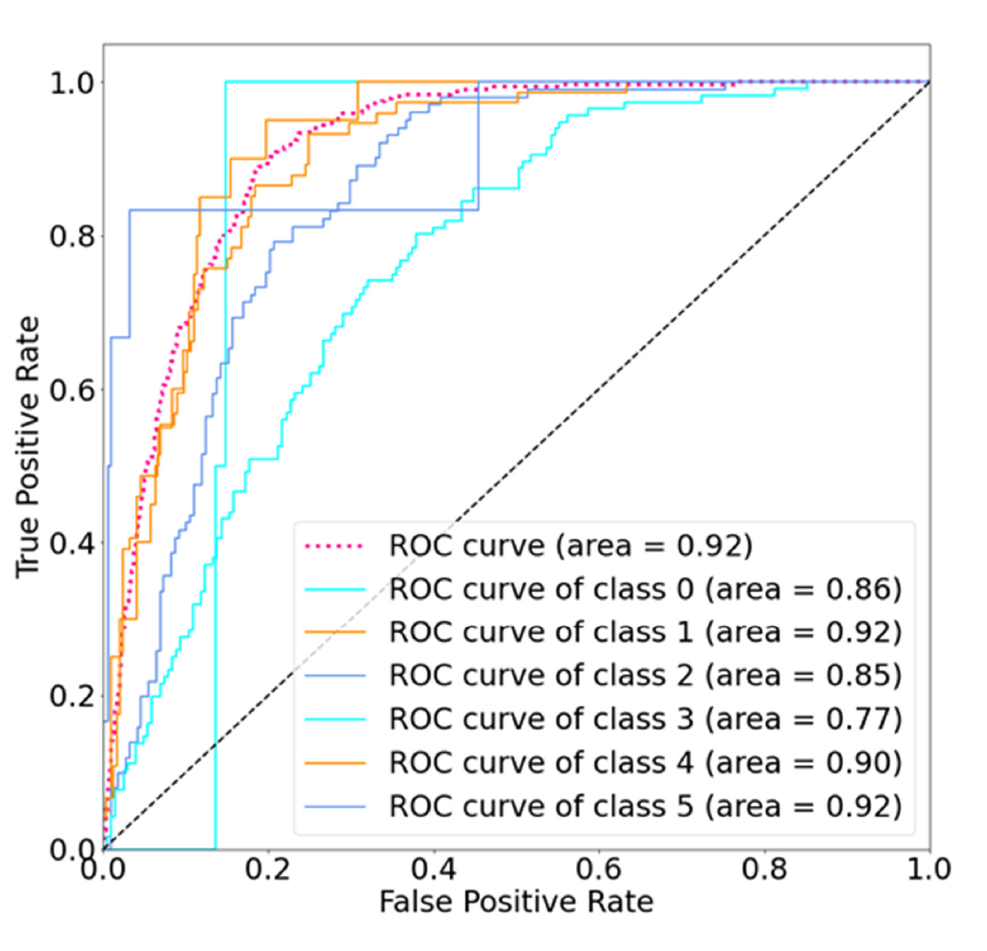
Figure 4. Receiver operating characteristic curve of SolaNet.